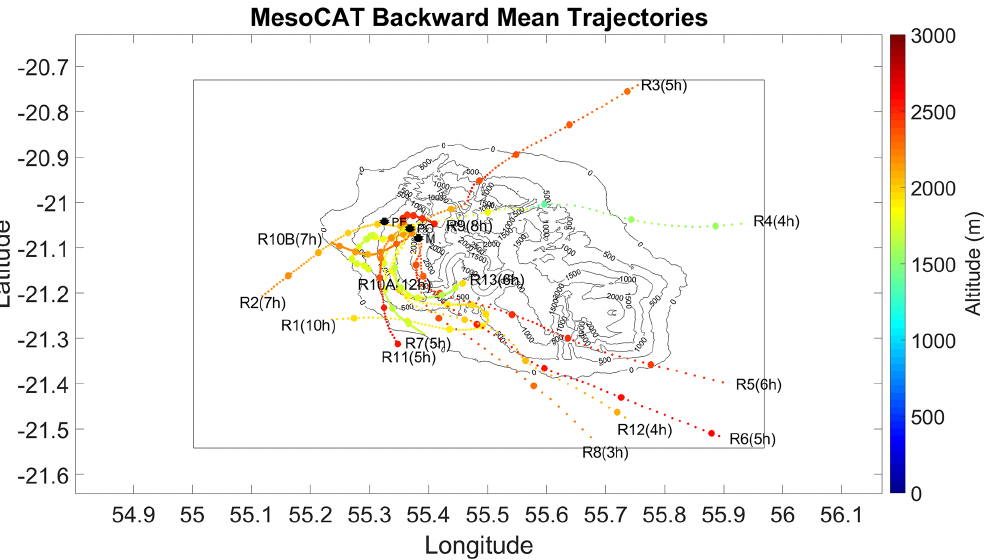
Figure 10. Average back trajectories for each cloud event (R1 to R13) obtained by the MesoCAT model. Small dots represent the air mass position every 5min and large dots every hour, limited by the model resolution. Trajectories are colour-coded (minimum and maximum of the air mass altitude) by the average